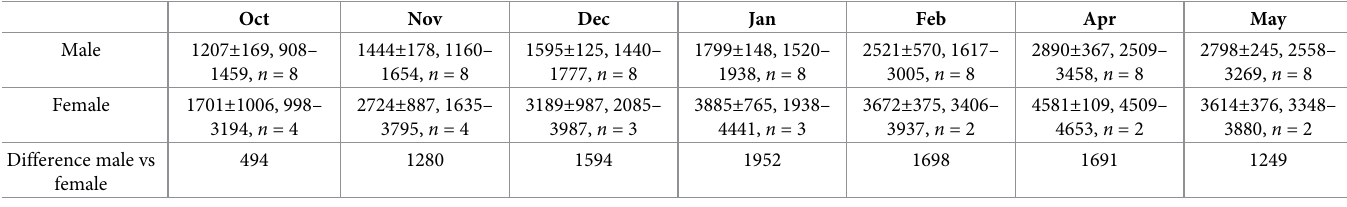
Table 2. Mean monthly distance of male and female puffins from the breeding colony in northwest Greenland.